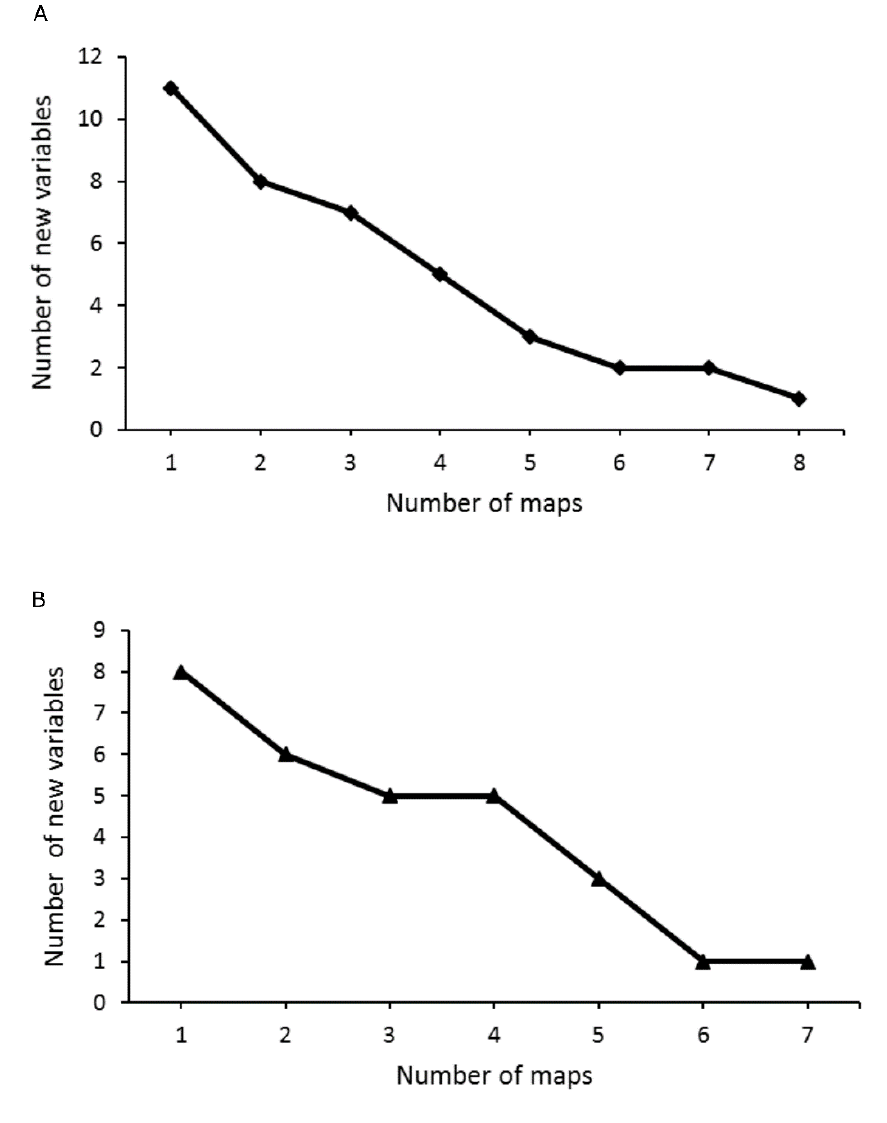
Figure A1.1: Accumulation of new variables for a) the bushmeat hunting and b) the bushmeat consumption Fuzzy cognitive maps, per individual map